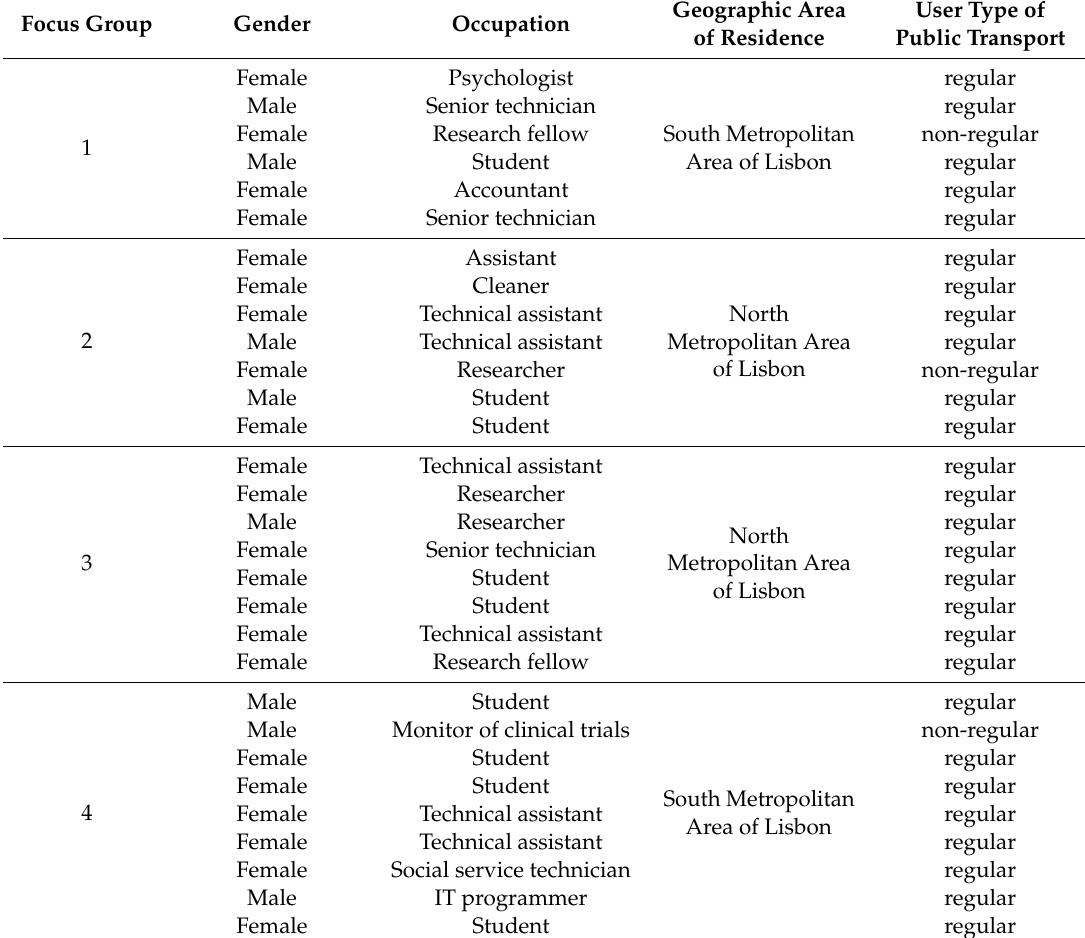
Table A2. Description of focus group